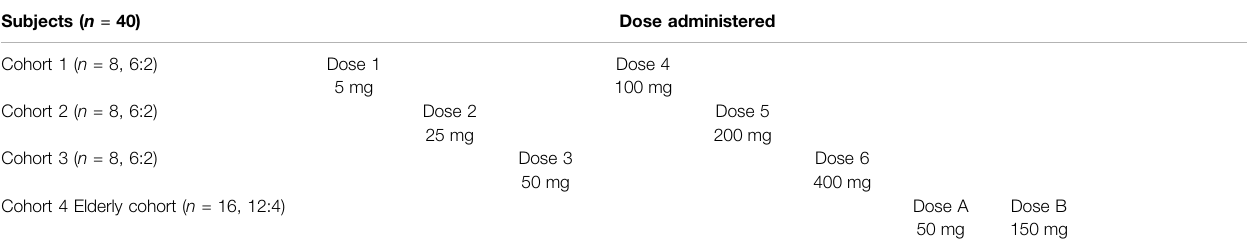
TABLE 1 | Dose escalation in the single ascending dose study. Subjects ( n = 40) Dose administered Cohort 1 ( n (cid:1) 8, 6:2)